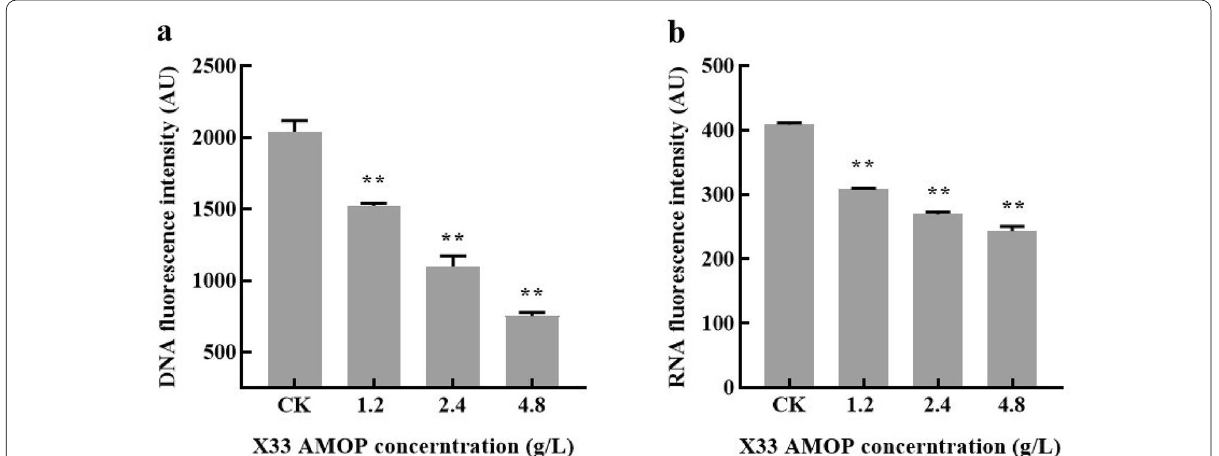
Fig. 7 Effects of X33 AMOP treatment on the nucleic acid degradation of P. digitatum . a X33 AMOP induced DNA degradation. b X33 AMOP induced RNA degradation. DAPI was used as a fluorochrome for the indirect measurement of DNA and RNA concentration. The data were shown as the mean SD ( n 3), p < 0.05, p < ± = ∗ ∗ ∗